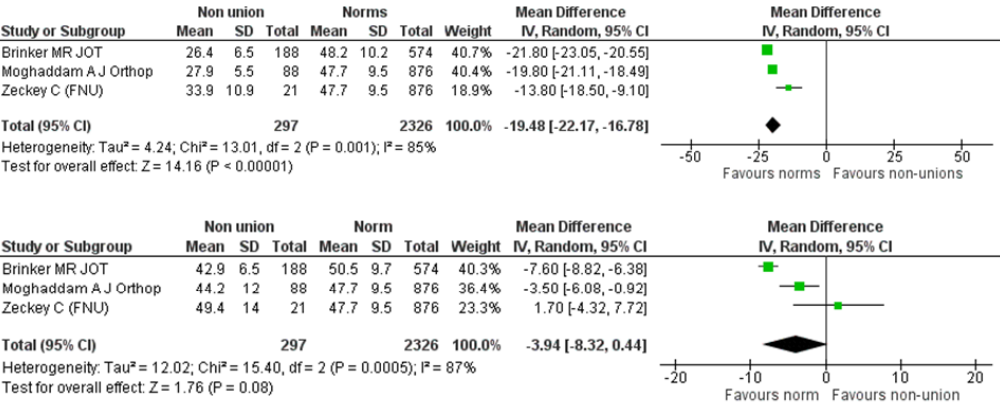
Figure 8. SF-12 PCS and MCS pooled analysis between femoral non-unions and norm.